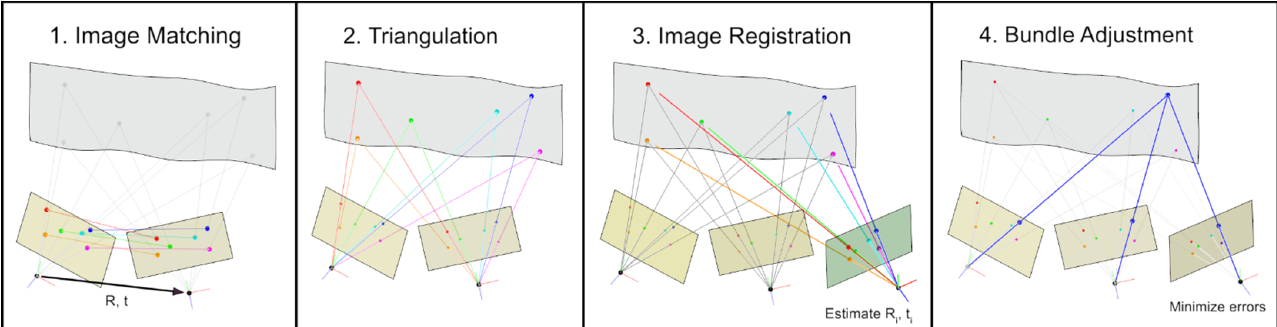
Figure 4. Schematic of the Structure from Motion procedure.